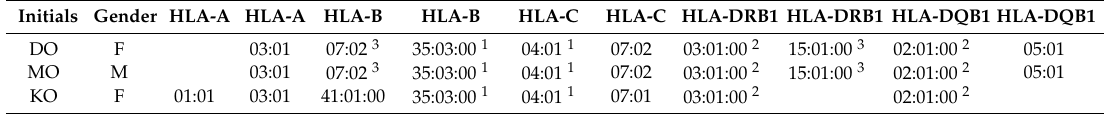
Table 2. Human leukocyte antigen (HLA) genotyping results in the three siblings. Initials Gender HLA-A HLA-A